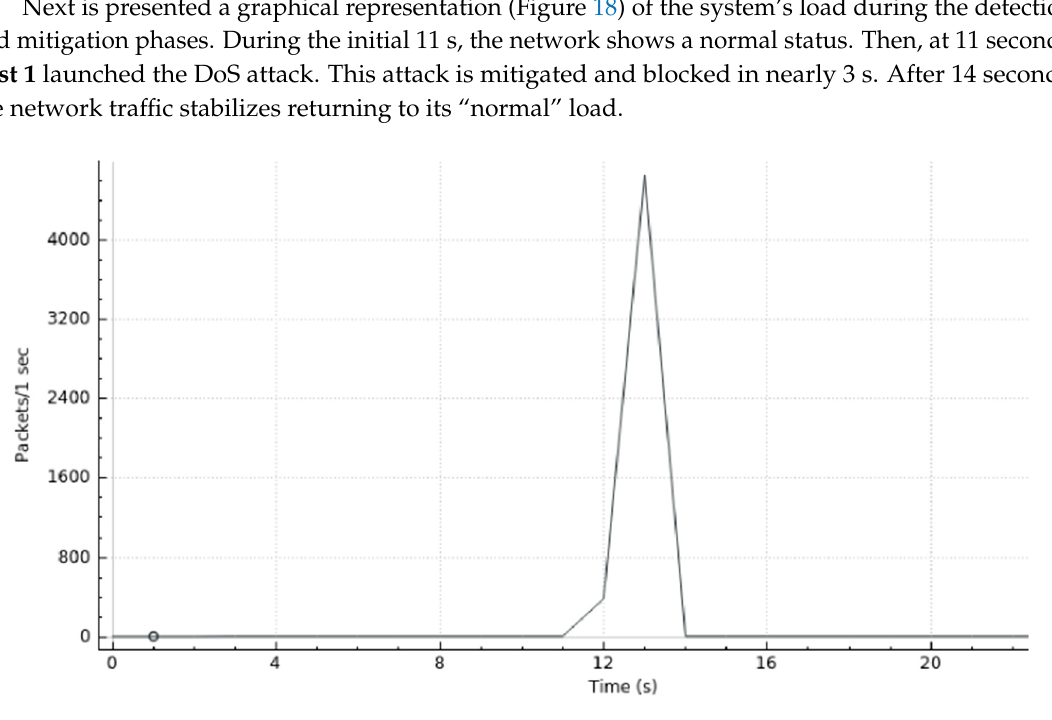
Figure 18. Scenario III—DDoS Detection and Mitigation.